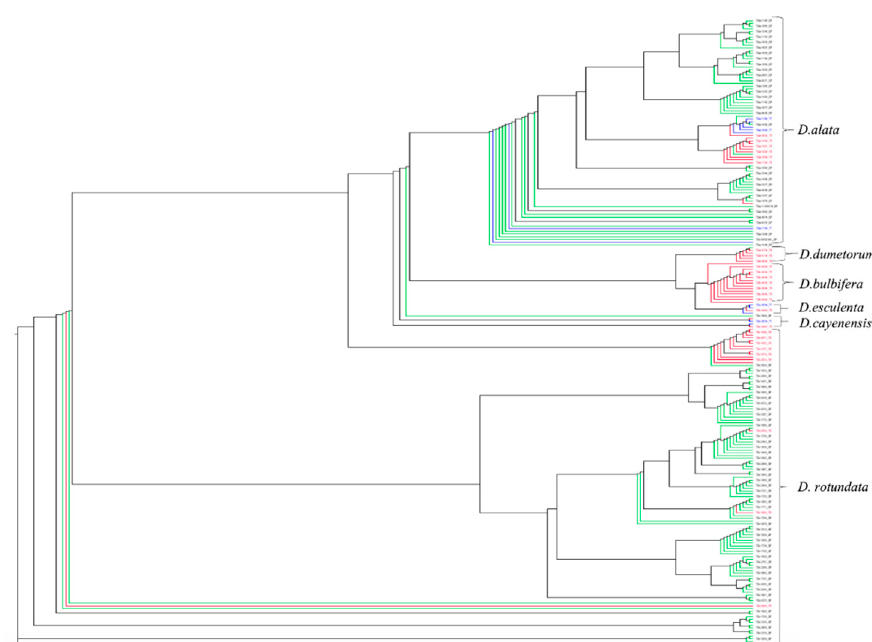
Figure 4. The phylogenetic tree constructed using DArTseq genotyping data on 230 cultivated Dioscorea spp. accessions and Neighbor-joining method to assess the genetic relationship among the accessions and different species and their ploidy levels. Green color = diploid (2x), red color = triploid (3x) and blue color = tetraploid